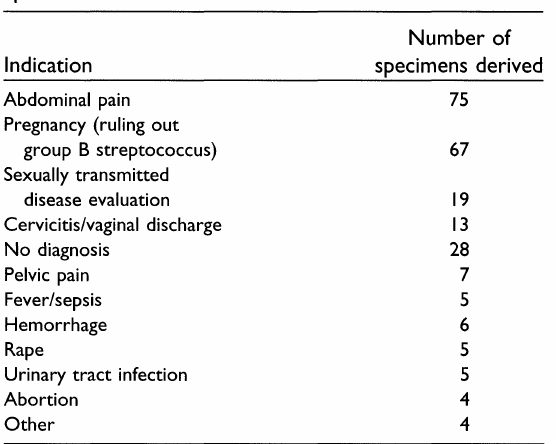
TABLE I. Clinical setting from which vaginal specimens were